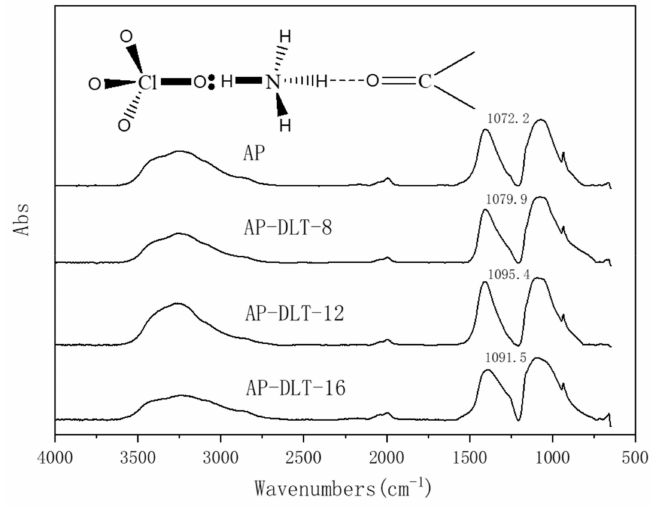
Figure 3. Micro-infrared spectra of ammonium perchlorate (AP) and AP coated with DLT-8, DLT-12 and DLT-16, and the interaction mechanism between the bonding agents and AP (inserted